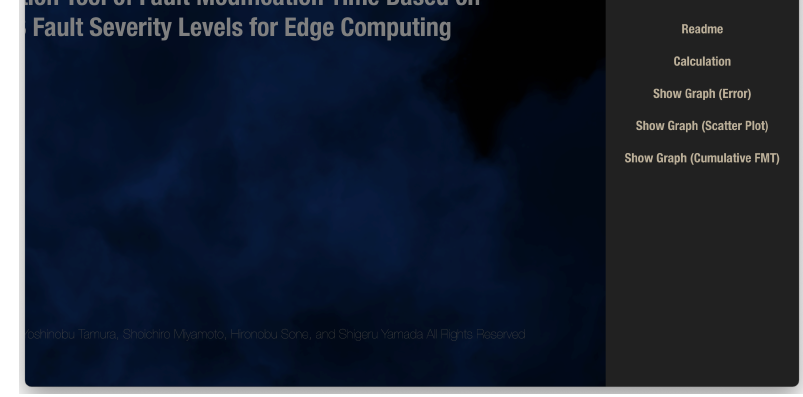
Figure 7. The menu of our tool.